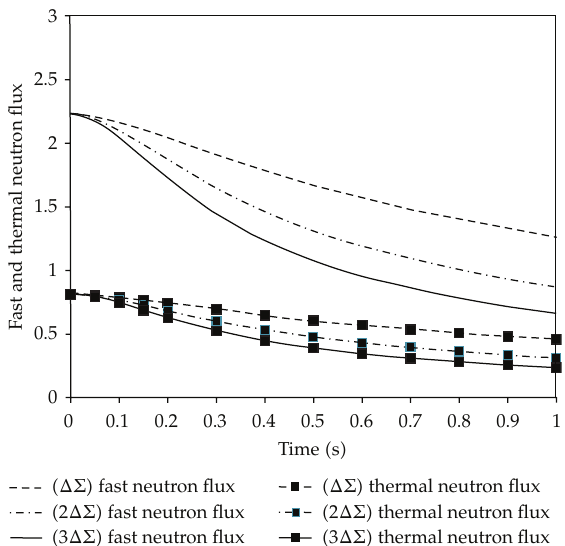
Figure 4: Fast and thermal neutron flux at a negative ramp reactivity.